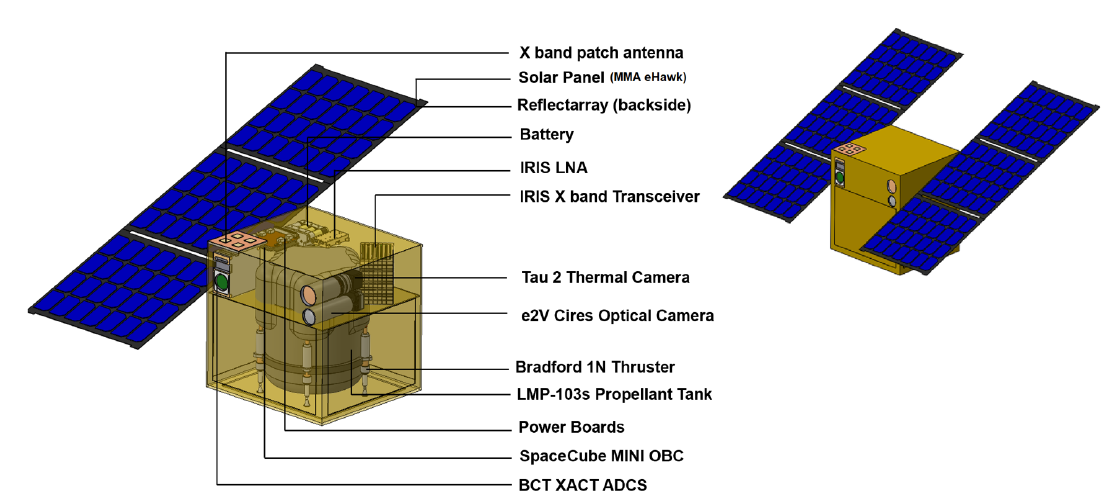
Figure 3. Spacecraft Layout with components shown ( Left ). Spacecraft fully assembled with pair of solar panels ( Right ).